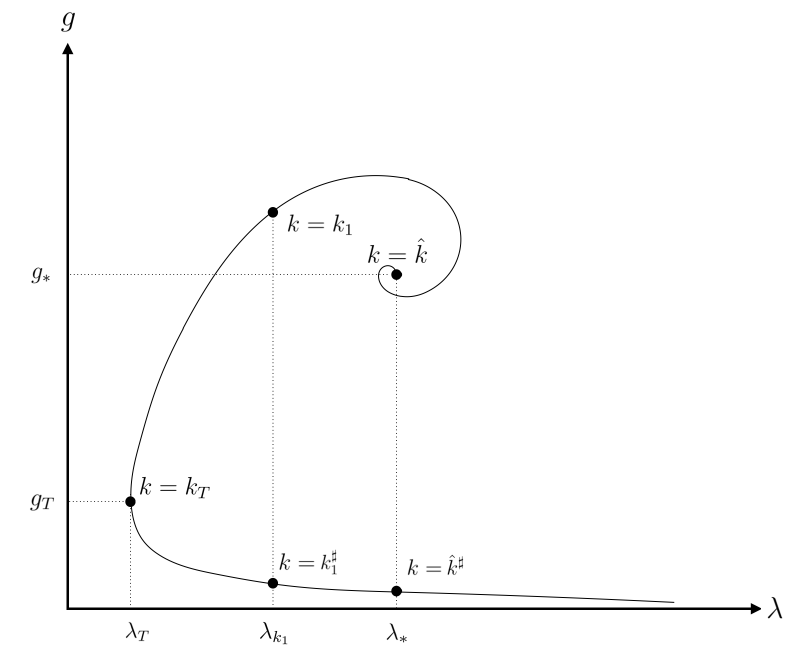
Figure 7. A typical RG trajectory of Type IIIa on the g - λ theory space. The duality transformation k 7→ k 2 /k is seen to map the scale k 1 onto its dual k ] T (2) Dimensionless cosmological